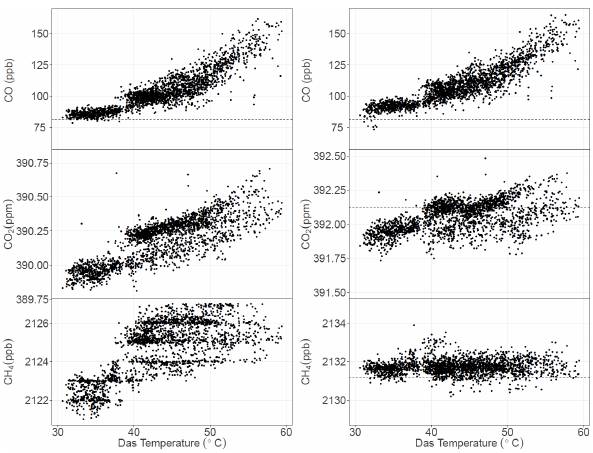
Figure 5. Correlation plot between the raw (left) and span- calibrated (right) working gas CO, CO 2 , and CH 4 mixing ratios and DAS instrument